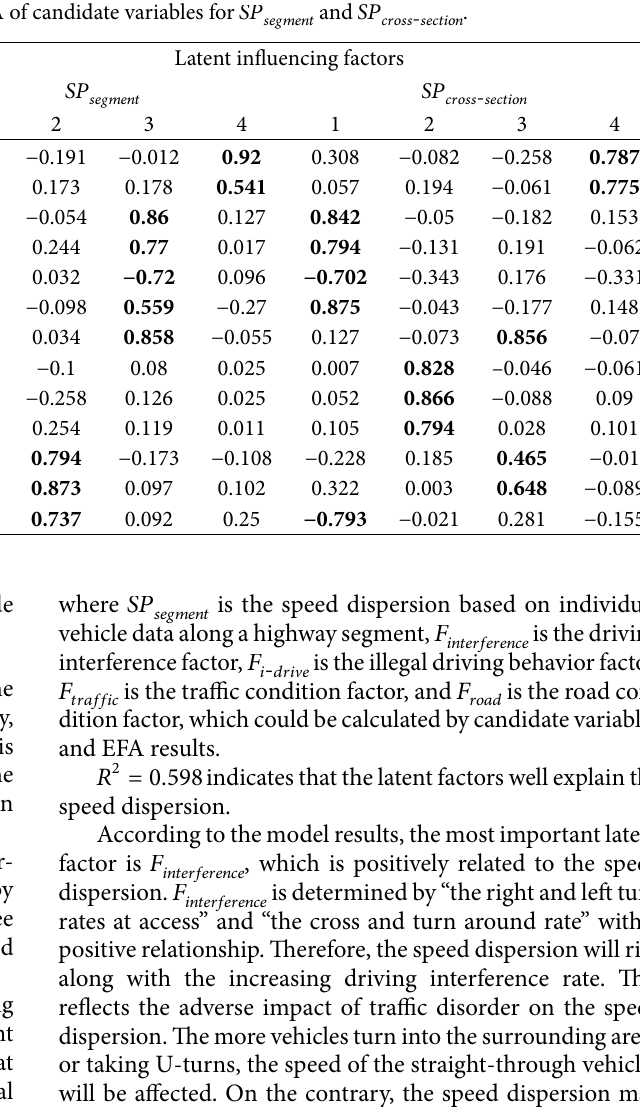
Table 4: Rotated factor loadings for the EFA of candidate variables for